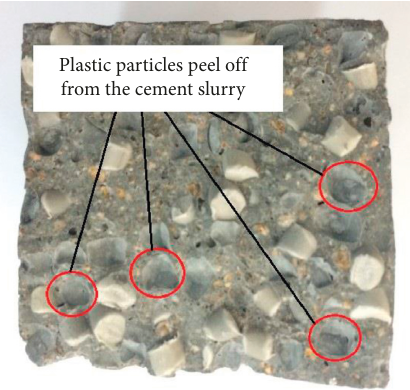
Figure 6: The photograph of the mortar’s fracture